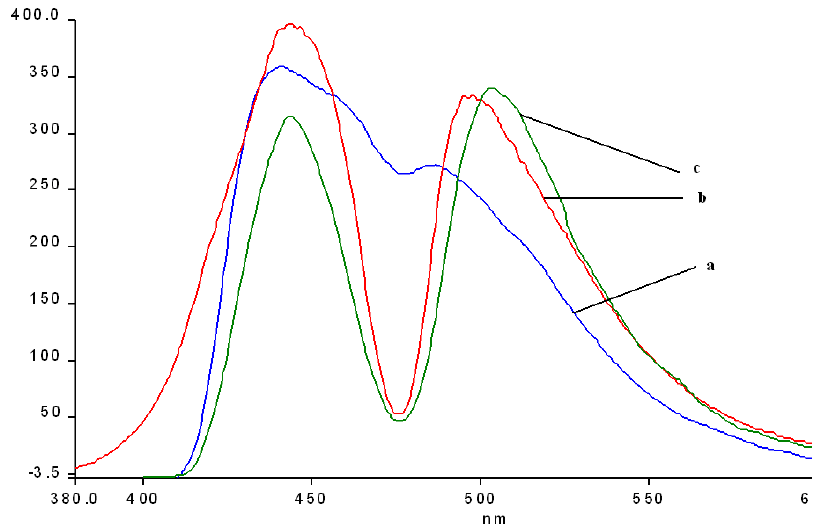
Figure 12. Overlapped emission spectra of hybrid nanomaterials obtained by impregnation of 2b (line a) into the silica matrix 2b-A (line b) ; 2b-AB (line c) in THF, at the same